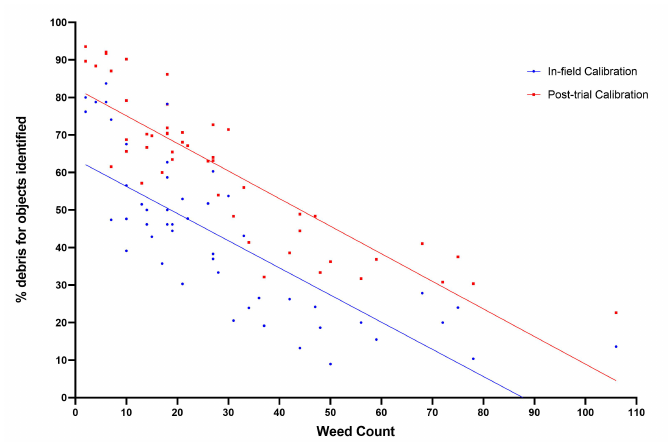
Figure 15. Proportion of objects identified which are debris versus weed count.